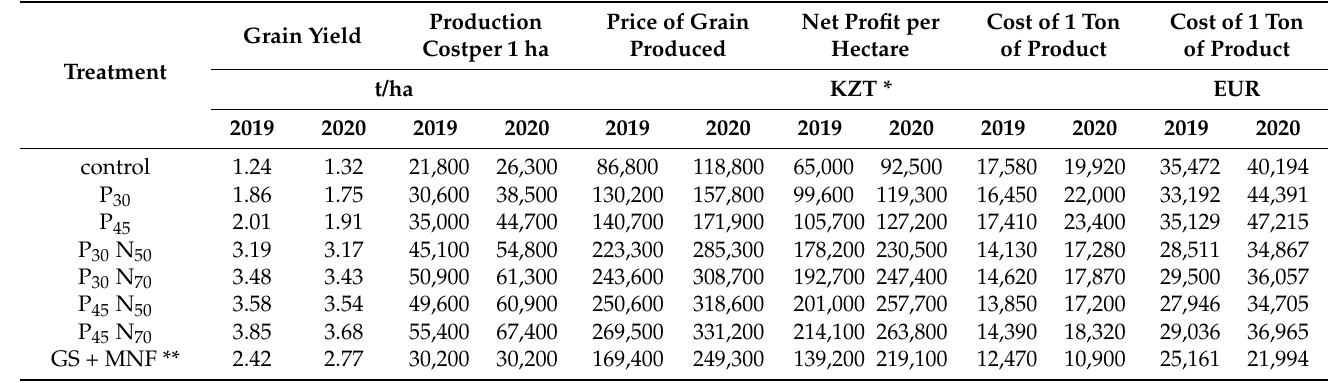
Table 7. Economic efficiency of fertilizers used in the cultivation of winter wheat with